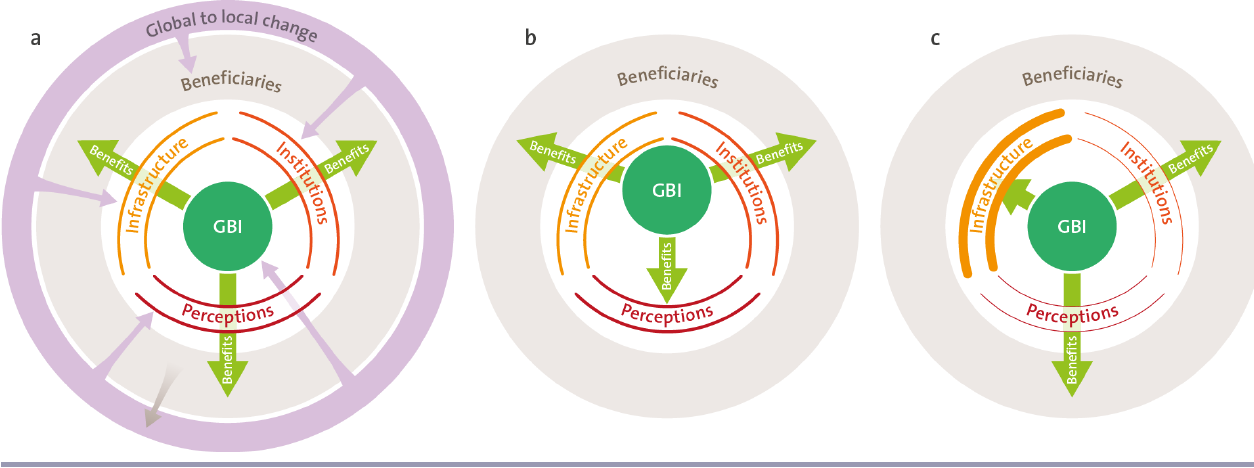
Fig. 1 . The combination of three filters, infrastructure, institutions, and people’s perceptions and capacities, frame and influence the flow of ecosystem service benefits from urban green and blue infrastructure to urban residents. The filters exist, and manifest differently, across scales and the filtering effect will depend on the nature of the benefits: ecosystem service benefits are quite diverse, which is also reflected in how they interact with the filters. Cities are under constant pressure by drivers from the outside (external), including financial interests and investments, immigration, demographic changes, climate change etc., as well as internal processes of change and system feedback loops (a). System change can affect the flow of benefits from green and blue infrastructure (GBI) either directly by changing GBI itself, e.g., by changing its extent, quality, or composition (b), or by changing the filters around GBI and thereby their effect on the flows of benefits (c). The overall filtering is a combined effect of all three filters, and by working actively with aligning filters in (b) and (c) offers flexible ways for ensuring that the flows of benefits are